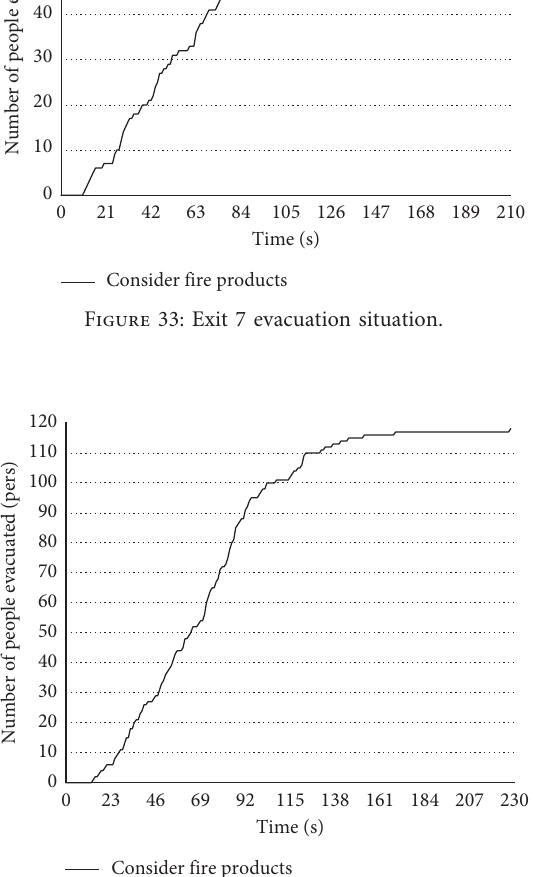
Figure 32: Exit 6 evacuation situation.